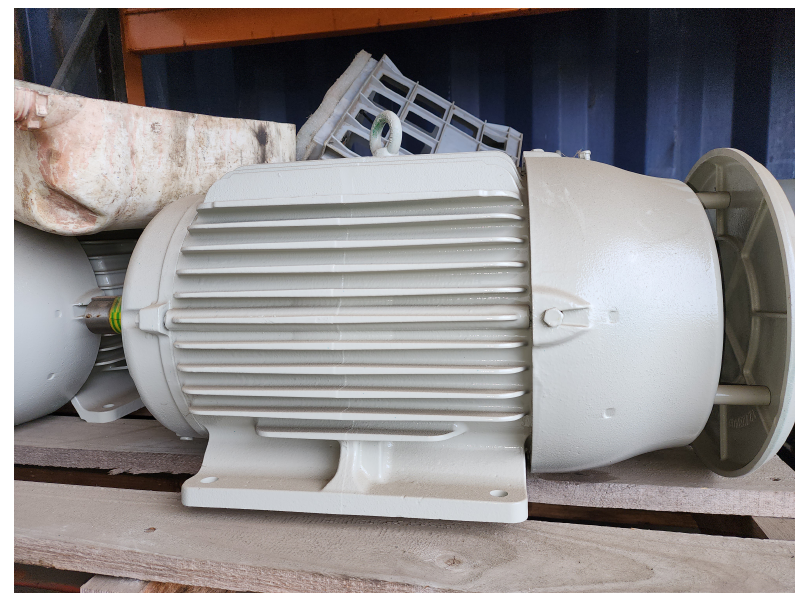
Figure 2. Totally Enclosed Fan Cooled (TEFC)